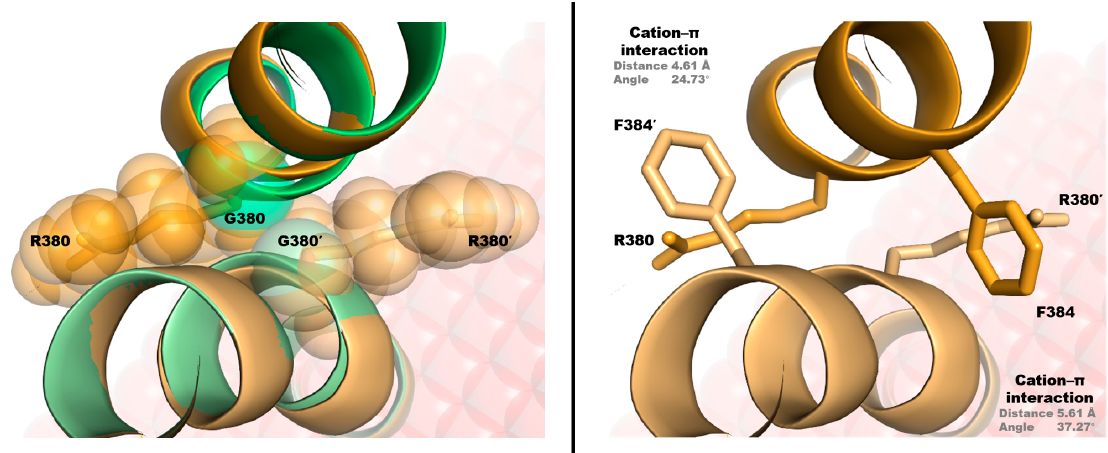
Figure 3. Left panel . Mutant FGFR3 superposed on native FGFR3. The transmembrane helices of the FGFR3 G380R monomers are colored in pale orange and bright orange, respectively. Right panel . Favorable noncovalent interactions between the arginyl and phenylalanyl residues. Distance is the length of space between the positive charge center and the centroid of the aromatic ring; angle is the amount of rotation between the line joining the cation to the centroid and the normal to the aromatic plane at the